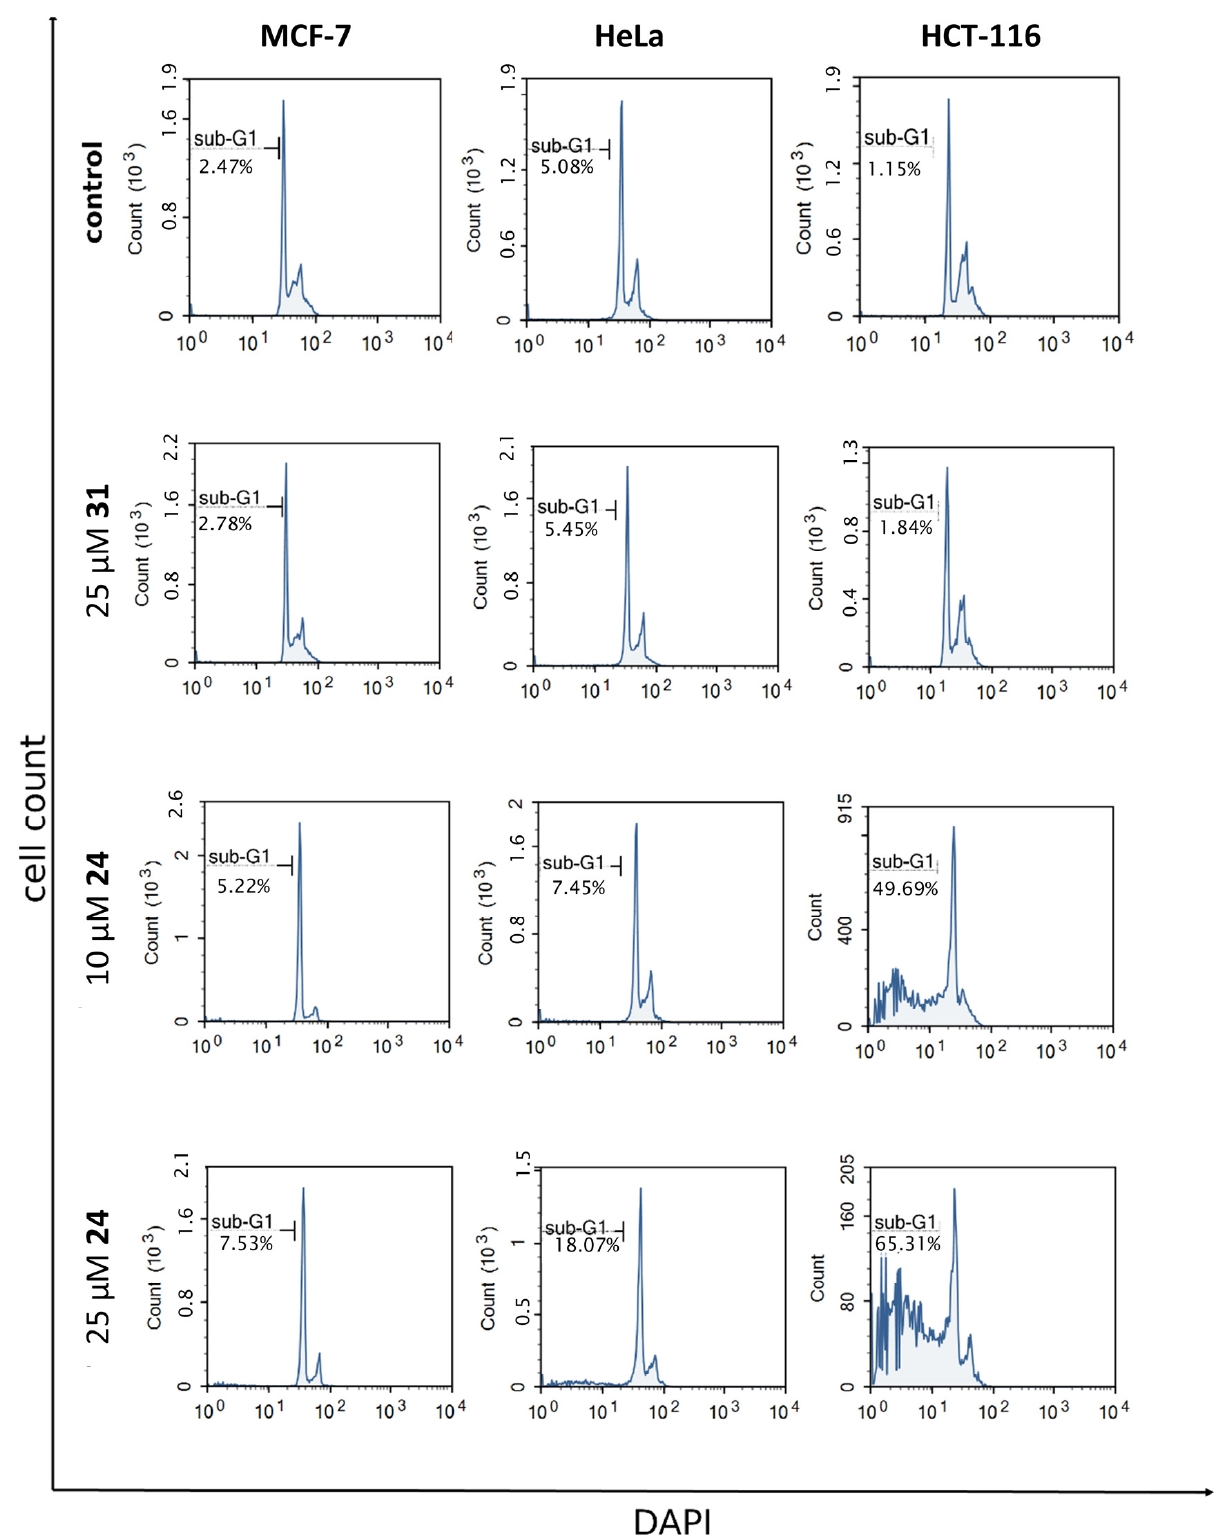
Figure 8. MCF-7, HeLa, and HCT116 cell cycle phases after 72h induction with 24 [10 µ M or 25 µ M] or 31 [25 µ M]. On histogram, sub-G1 phase of cell cycle is visible.